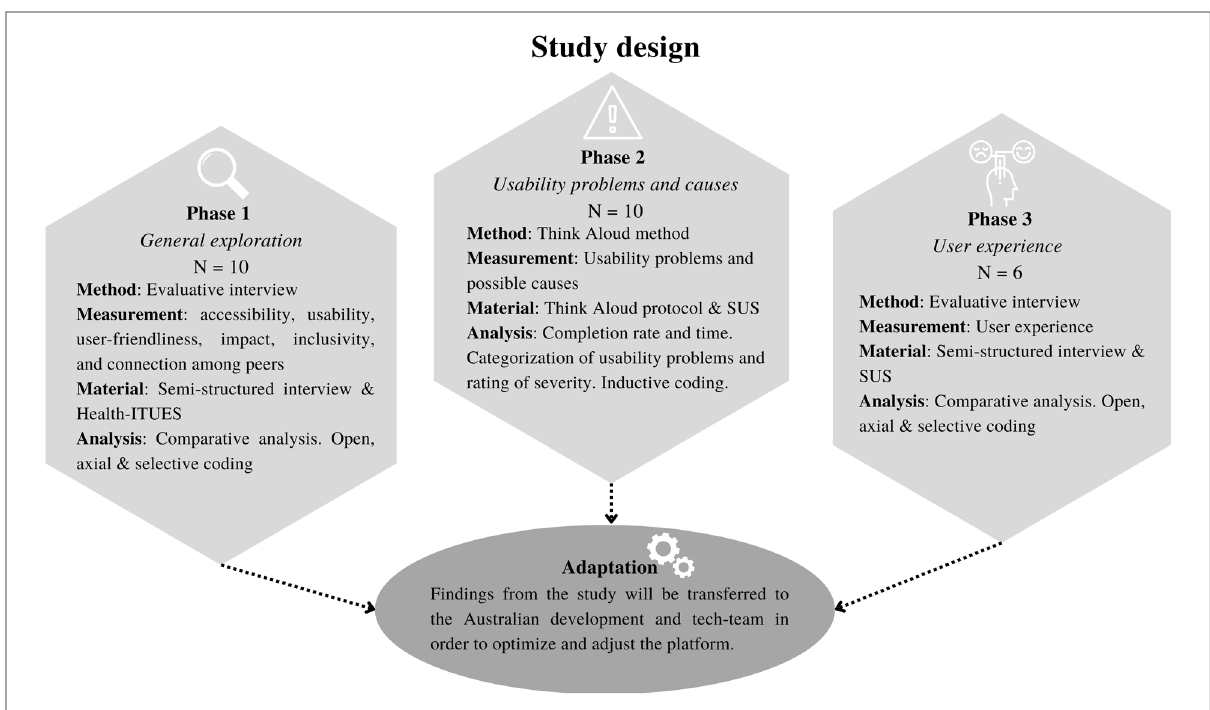
FIGURE 1 Study design. N, amount of participants; SUS, System Usability Scale; Health-ITUES, Health Information Technology Usability Evaluation Scale. For categorization of usability problems see Krushnik & Patel (2004), for Nielsen Severity Scale, see Nielsen (1994) in “ Data analysis — phase 3 ”